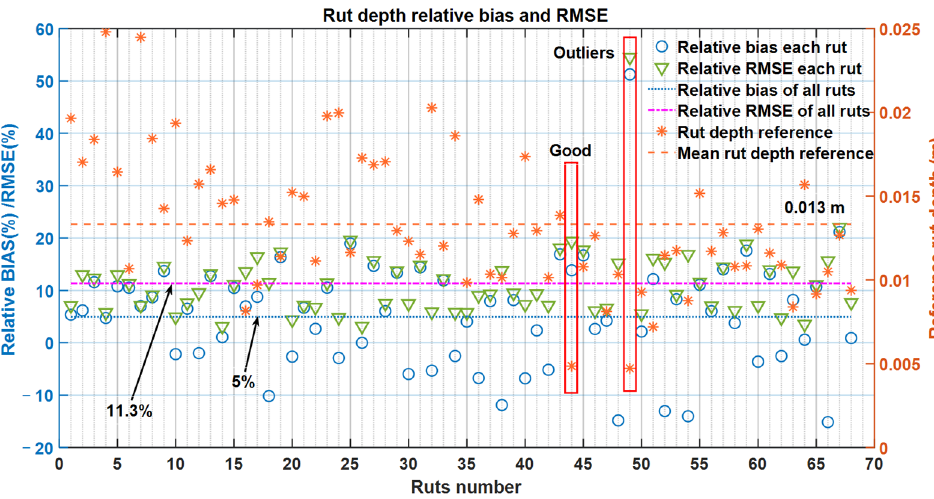
Figure 19. Individual and overall relative bias and root-mean-square error (RMSE) of all the ruts.